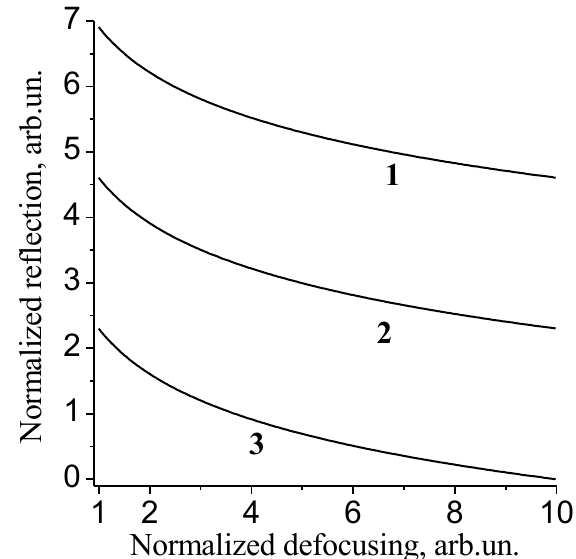
Figure 5: The dependence of the normalized